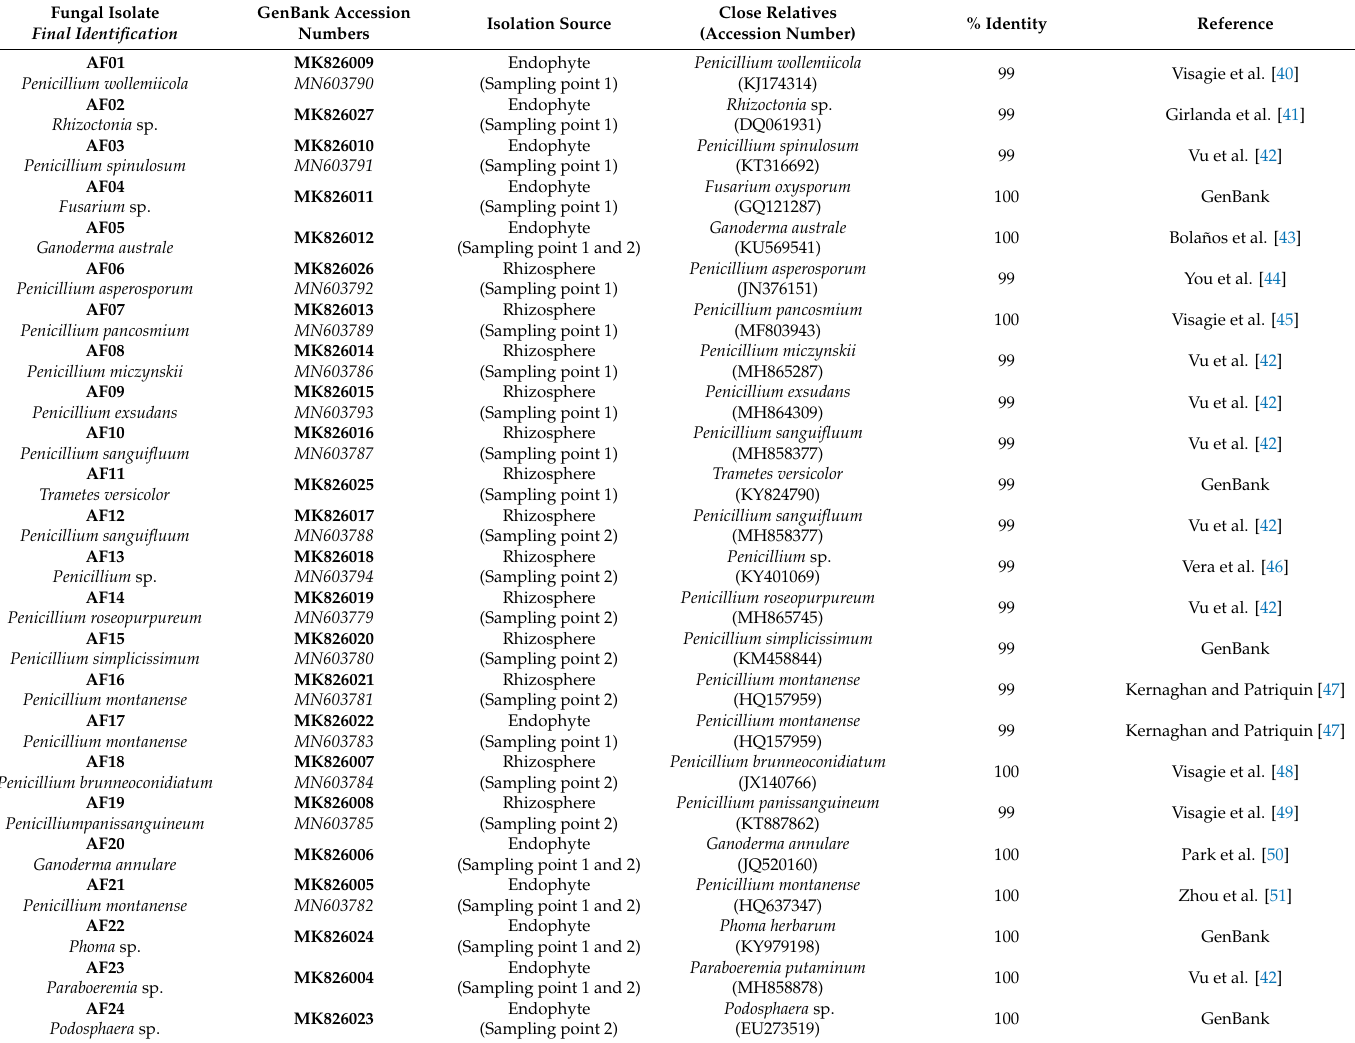
Table 3. Molecular identification of culturable fungi isolated from Arachnitis uniflora roots in southern Chile, based on the closest match in the GenBank database. GenBank accession numbers in bold are the sequences obtained with the ITS primers, whereas italic accessions are from the beta tubulin